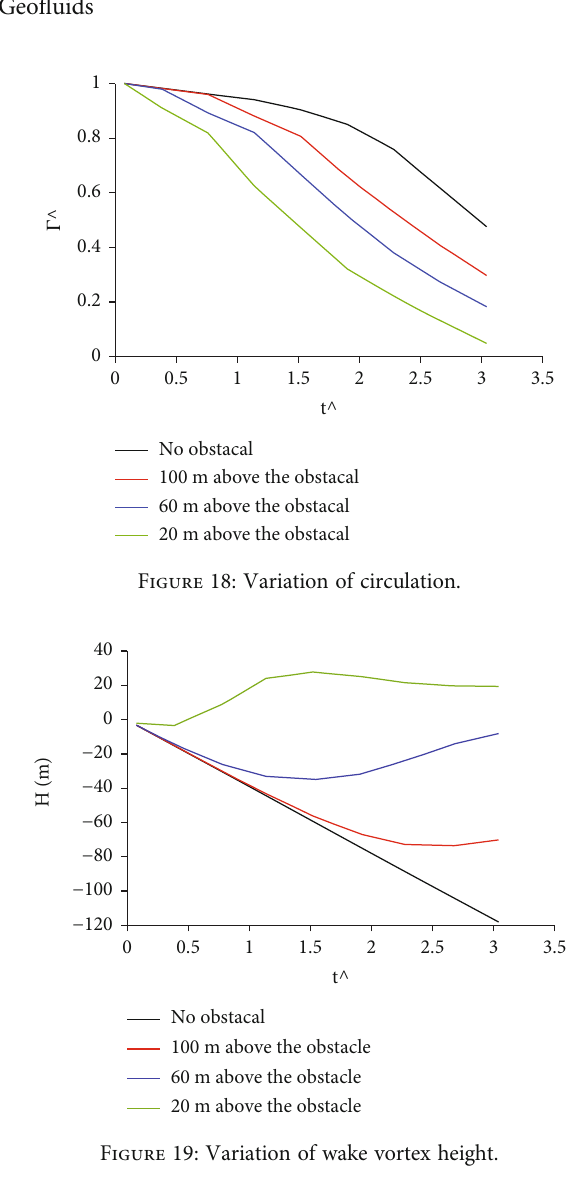
Figure 19 is the variation result of wake vortex height.